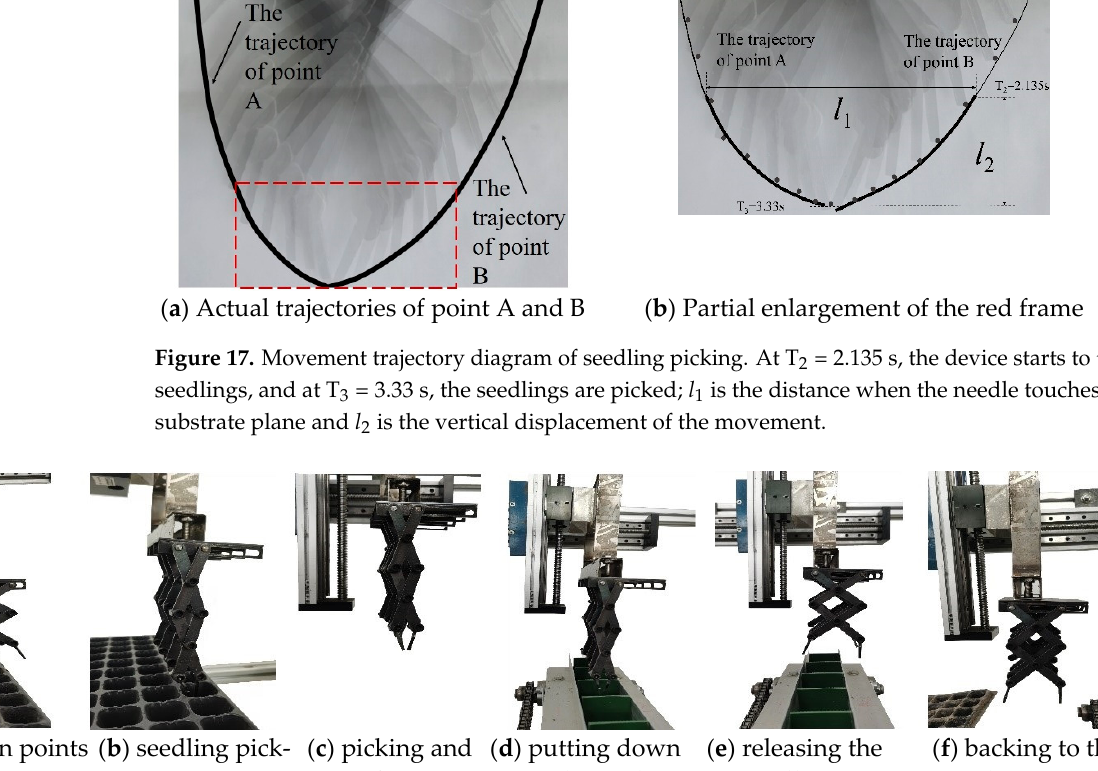
Table 3. Results of trajectory measurement.